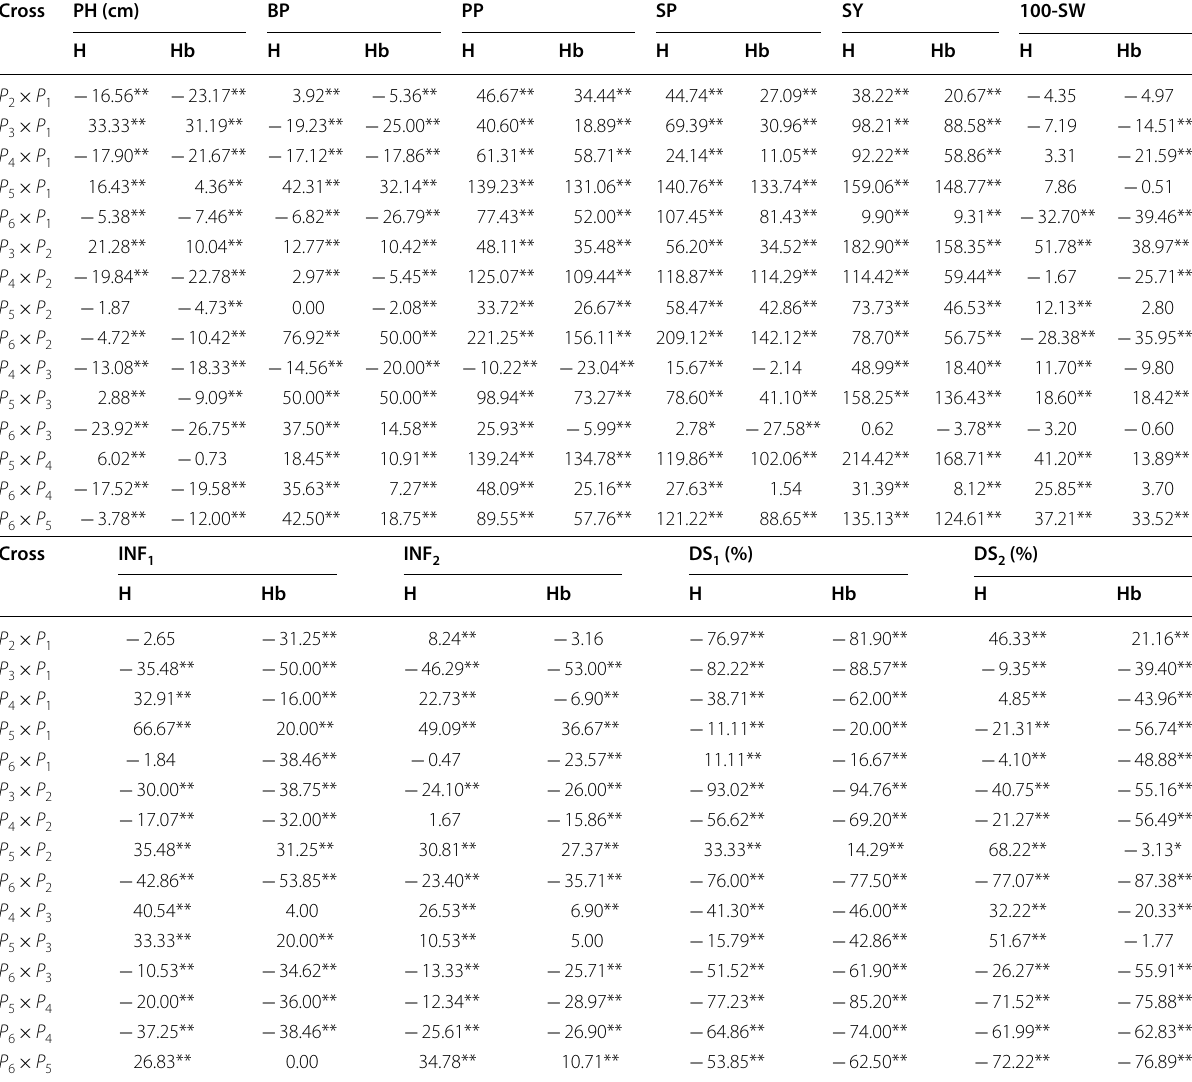
* and ** indicate significant and highly significant at 0.05 and 0.01 level of probability, respectively